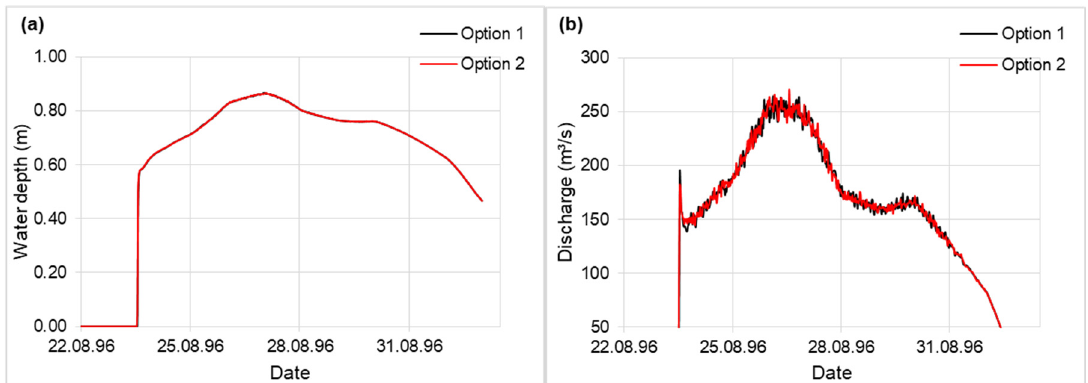
Figure 13. For levee-lowering options (Option 1: only vertical breach growth; Option 2: vertical and lateral breach growth) and the historical levee breach location of the August 1996 levee breach flood event at Wonji: ( a ) modelled water depth at an o ffi ce location; ( b ) modelled breach discharge. The o ffi ce location and the historical breach location are shown in Figure